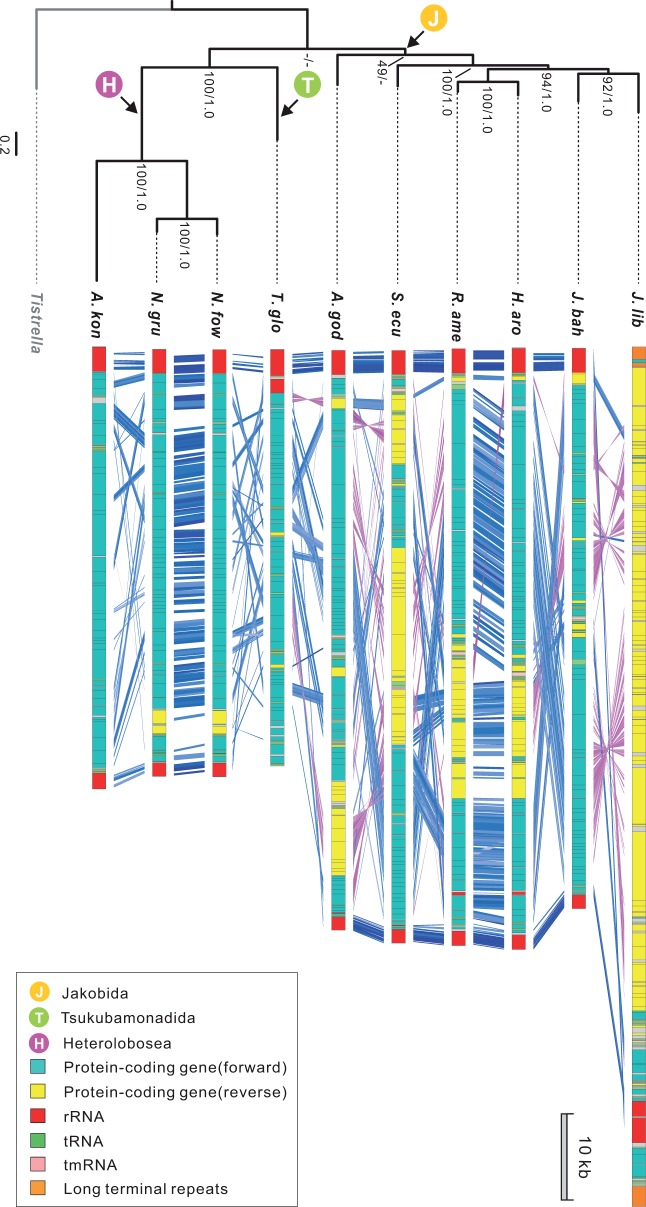
A mapping of overall mtDNA gene synteny between different lineages of Discoba (Heterolobosea, Tsukubamonadida, and Jakobida) onto a consensus phylogeny. The tree was based on a concatenated data set of 24 mitochondrial proteins (7,313 aligned amino acid positions), with the α-proteobacterium Tistrella mobilis (NC_017956) as outgroup. Numbers indicate maximum-likelihood bootstrap values with RAxML (Stamatakis et al. 2012) and posterior probabilities with PhyloBayes (Lartillot et al. 2013). Genes are color-coded by functional category as indicated in the box. Genes in the forward versus reverse order are indicated in blue and purple lines, respectively, as generated by ACT (Carver et al. 2005) with a cut off value of 40.